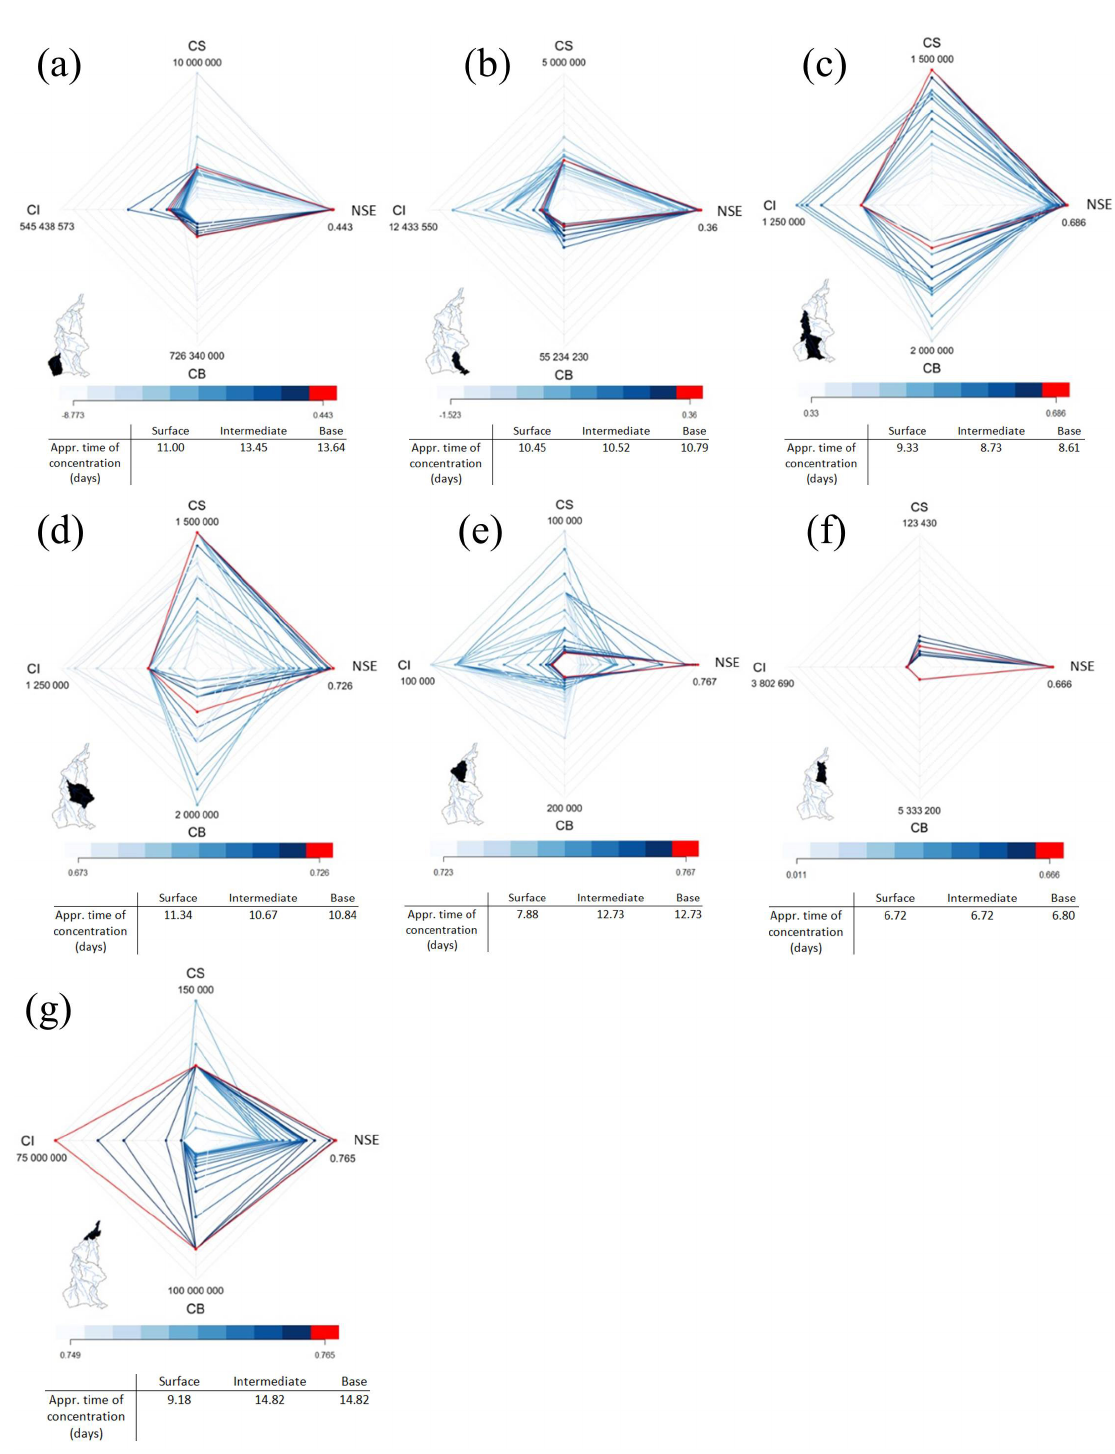
Hydrol. Earth Syst. Sci., 21, 4629–4648,